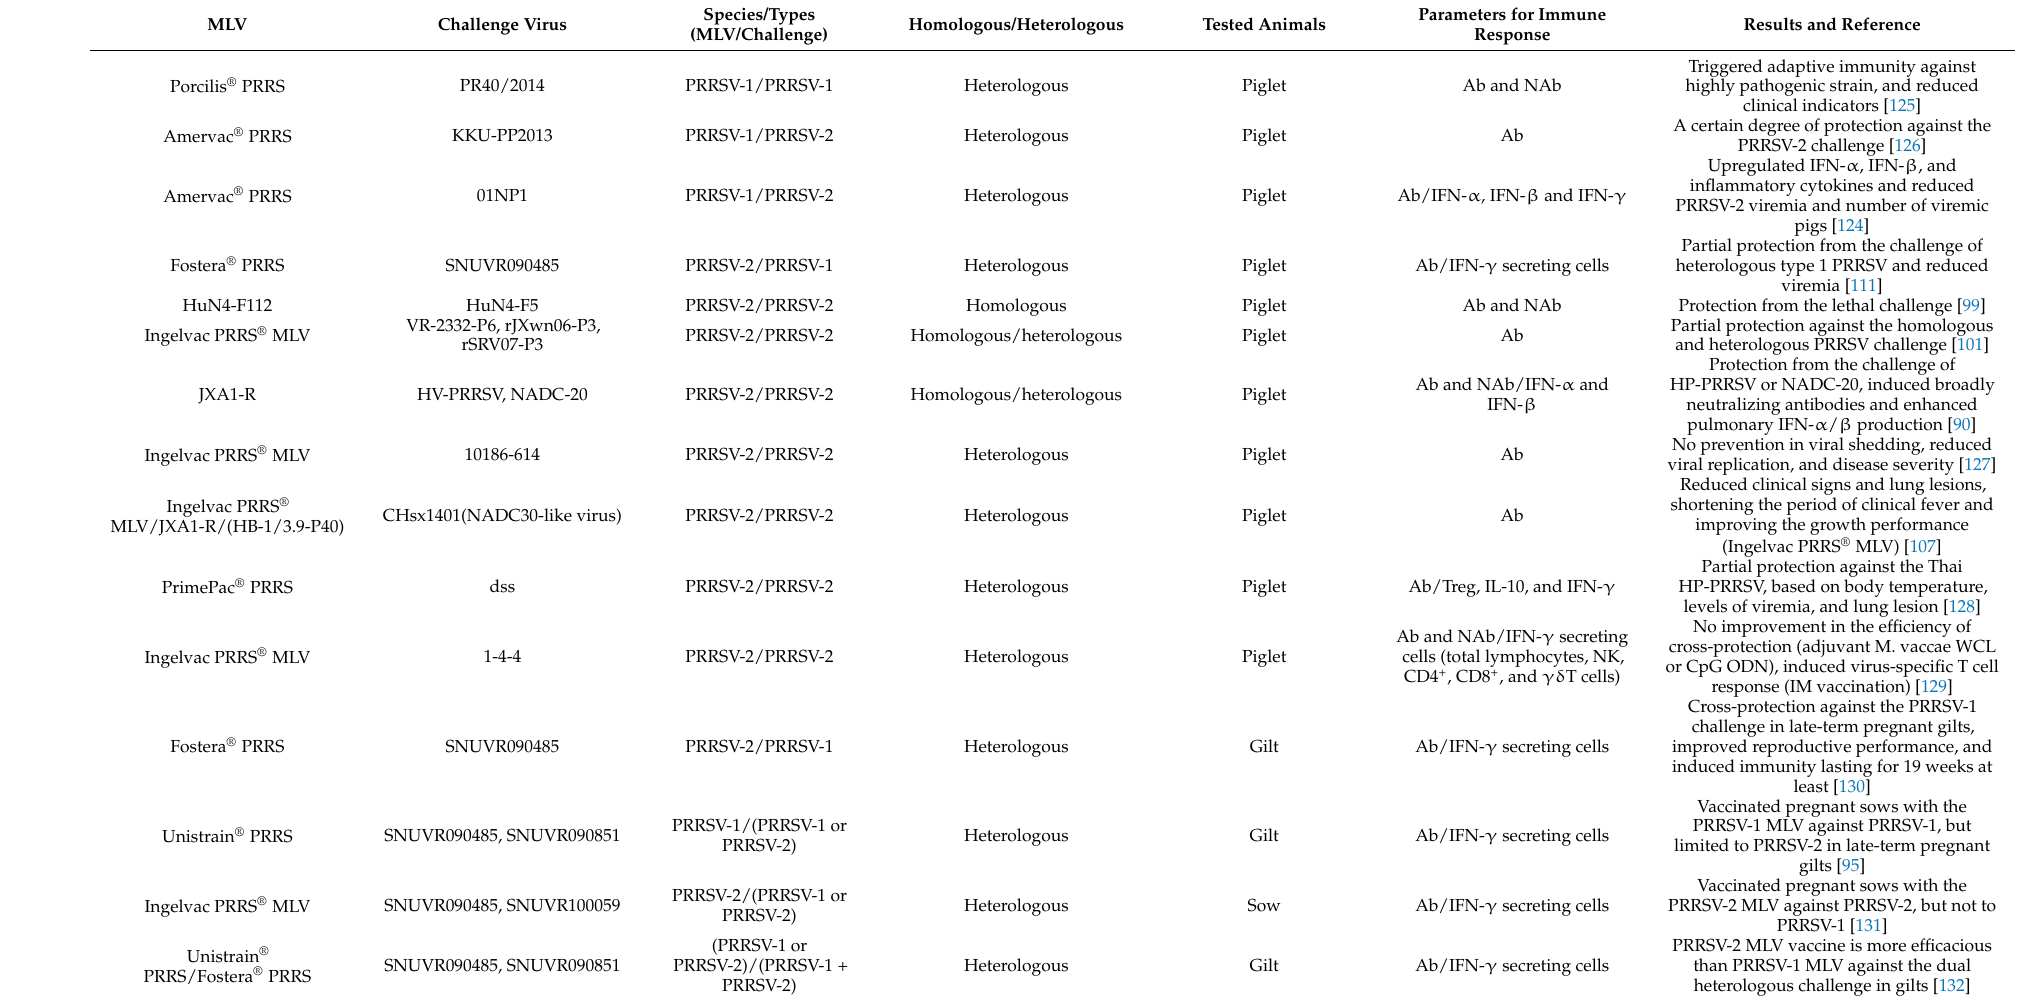
Table 2. Studies on evaluating cross-protection efficacy of commercial MLV